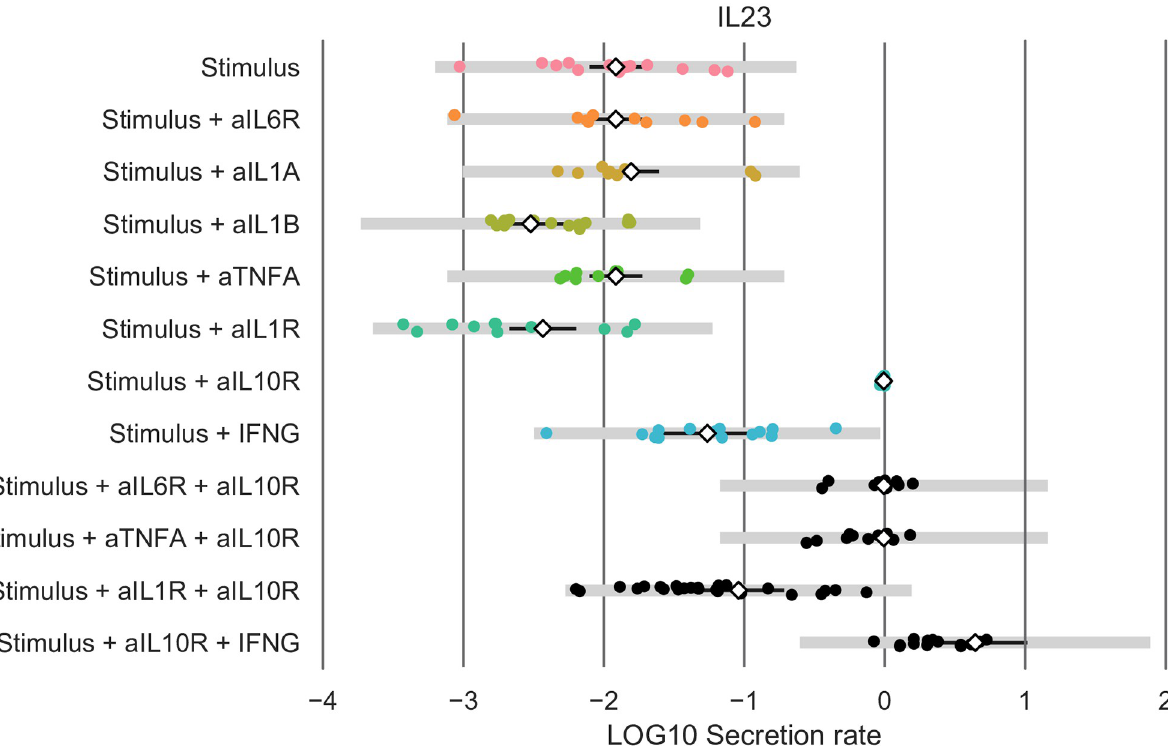
Fig 14. Model predictions by the selected, eighteen edge model for IL23 (white, diamonds) for various experimental conditions. We show the cytokine secretion dataset used for fitting (coloured dots, top eight rows) and the validation dataset (black dots, bottom four rows). We note that cytokine secretion data for all six cytokines (TNF α , IL1 α , IL1 β , IL6, IL10, IL23) was used for fitting, but only the IL23 data is shown in this figure. In 99% of cases, we expect an experimental data-point (grey lines, validation profile likelihood confidence intervals), or the true mean cytokine secretion rate (black lines, prediction profile likelihood confidence intervals) to lie within the shown intervals for our selected eighteen edge model predictions.